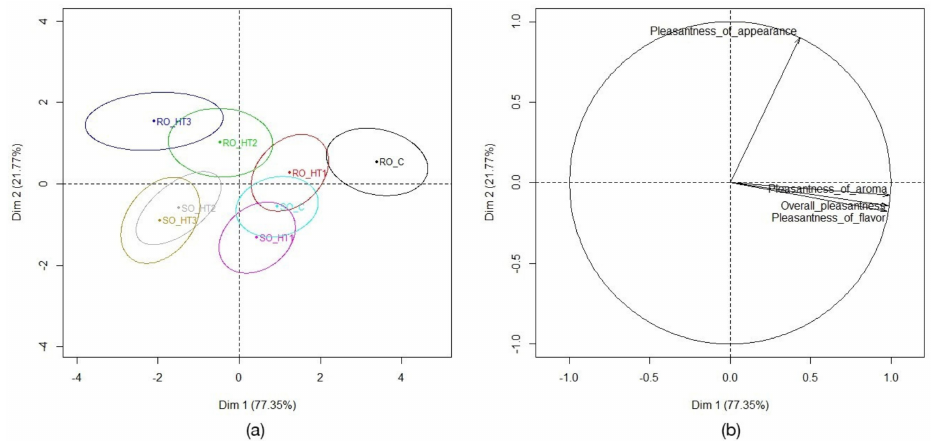
Figure 2. The results of PCA of hedonic analysis of oils before and after heat treatments: ( a ) Confi- dence ellipses for the mean points (RO_C, rapeseed oil control; RO_HT1, rapeseed oil samples after 1st heat treatment; RO_HT2, rapeseed oil samples after 2nd heat treatment; RO_HT3, rapeseed oil samples after 3rd heat treatment; SO_C, sunflower oil control; SO_HT1, sunflower oil after 1st heat treatment; SO_HT2, sunflower oil after 2nd heat treatment; SO_HT3, sunflower oil after 3rd heat treatment). ( b ) Variables factor